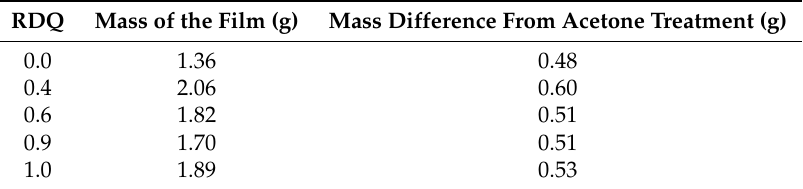
Table 3. Mass changes of films after acetone